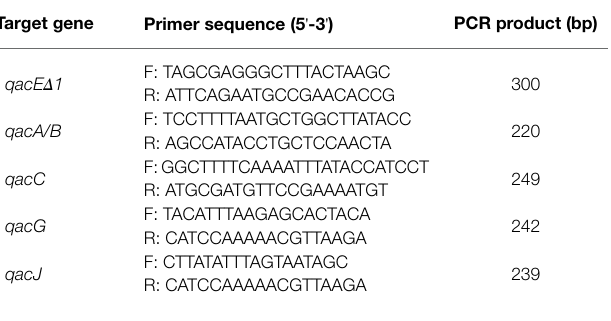
TABLE 3 | Primer sequences for amplification of quaternary ammonium resistance